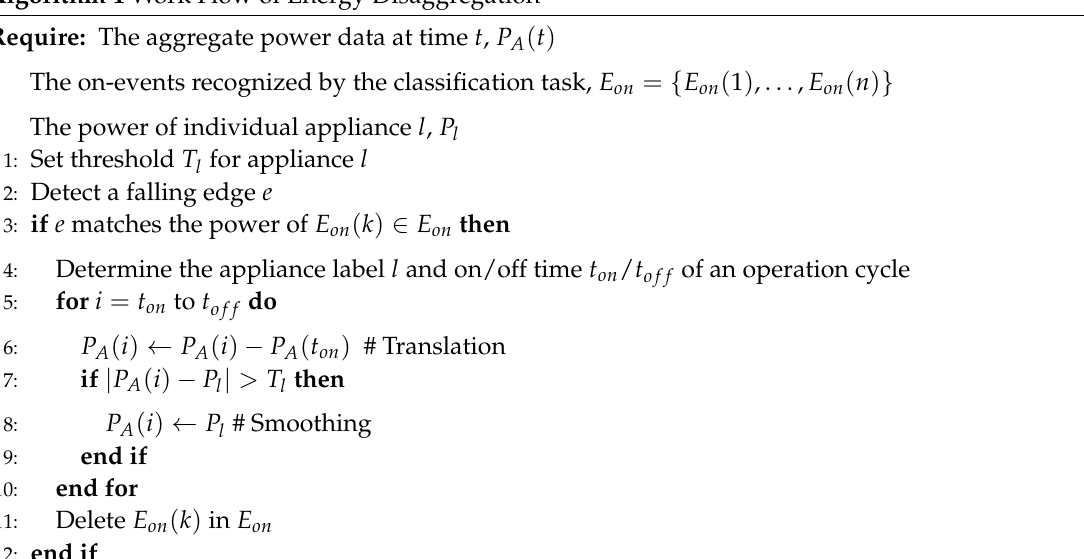
Algorithm 1 Work Flow of Energy